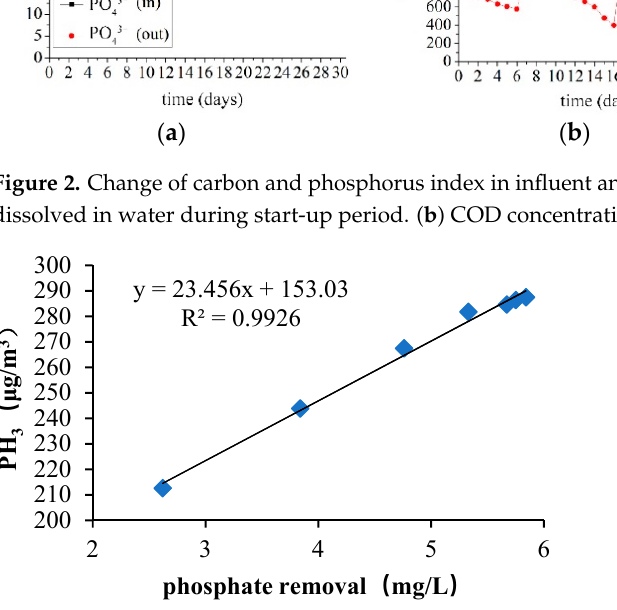
Figure 2. Change of carbon and phosphorus index in influent and effluent. ( a ) PO 43 − concentrations dissolved in water during start-up period. ( b ) COD concentrations during start-up period.